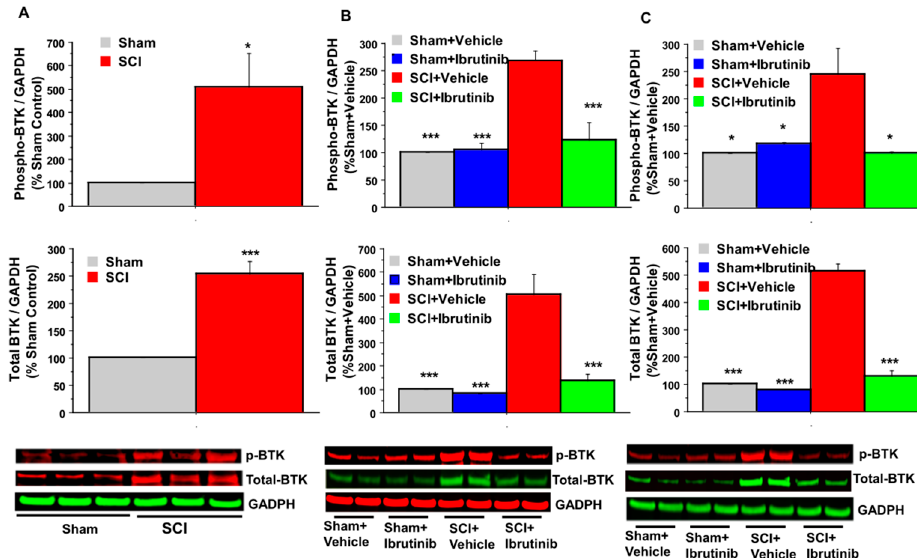
Figure 1. Effects of SCI and Ibrutinib treatment on BTK phosphorylation and total BTK protein analyzed by quantification of Western blotting data. Western blot analysis of spinal cord samples (60 µg of protein extract each sample) at lesion epicenter showed that contusion injury increased BTK phosphorylation and total BTK protein in the spinal cord 2 ( A ), 7 ( B ), and 14 ( C ) days post-injury compared with sham-operated animals. Ibrutinib treatment 6 mg/kg/day, Scheme 3 h post-injury for 7 and 14 days resulted in reduced levels of BTK phosphorylation and total BTK protein in the spinal cord lesion site at 7 ( B ) and 14 ( C ) days after contusive SCI compared with vehicle-treated animals. Quantification of total BTK/GADPH or phospho-BTK/GAPDH (%Sham control for 2-day time point and %Sham + Vehicle for 7 and 14 days- time points) after contusive SCI was performed by the fold of blot density (GAPDH as loading control). Antibodies were specific for the total BTK or BTK phosphorylation (phospho-BTK-Y223). Data are presented as mean ± S.E.M. (for 7-day time point, n = 4 per group, for 14-day time point, n = 2 per group) and analyzed with one-way ANOVA followed by Bonferroni post hoc analysis, ( B , C ): * p < 0.05, *** p < 0.001 compared to vehicle-treated SCI animals. ( A ): * p < 0.05, *** p < 0.001, compared to sham control, t -test, n = 3 per